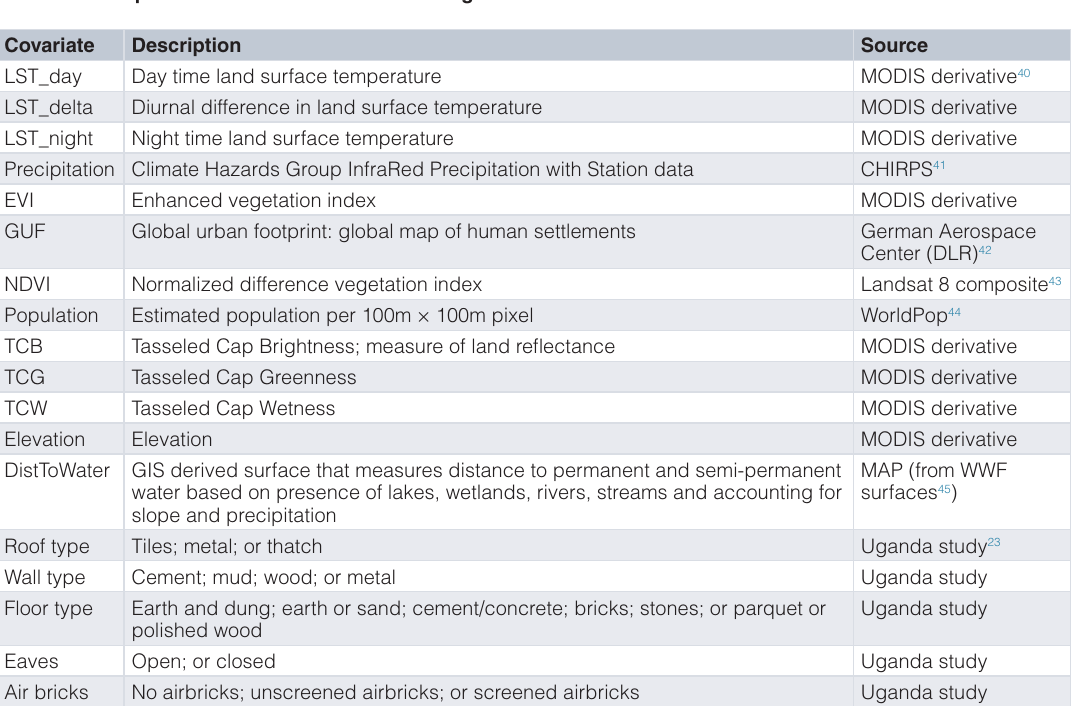
Table 1. Description of environmental and housing